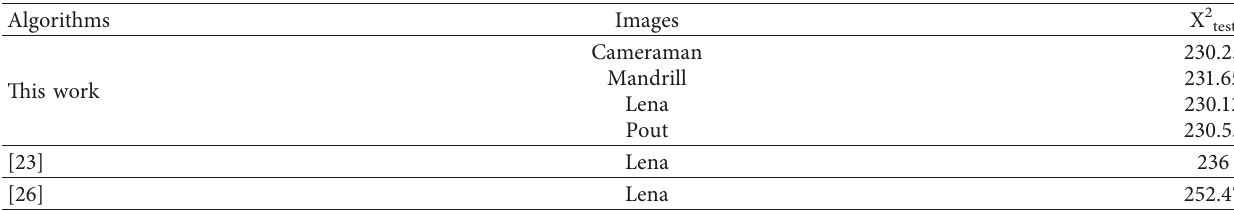
Table 6: Chi-square test analysis.